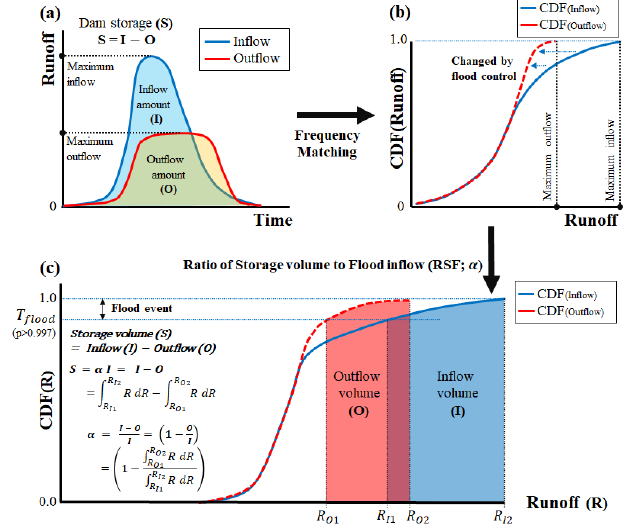
Figure 2. The concept of ratio of storage volume to flood inflow (RSF): ( a ) dam operation; ( b ) CDF plot of dam operation with frequency matching; ( c ) RSF formulation.